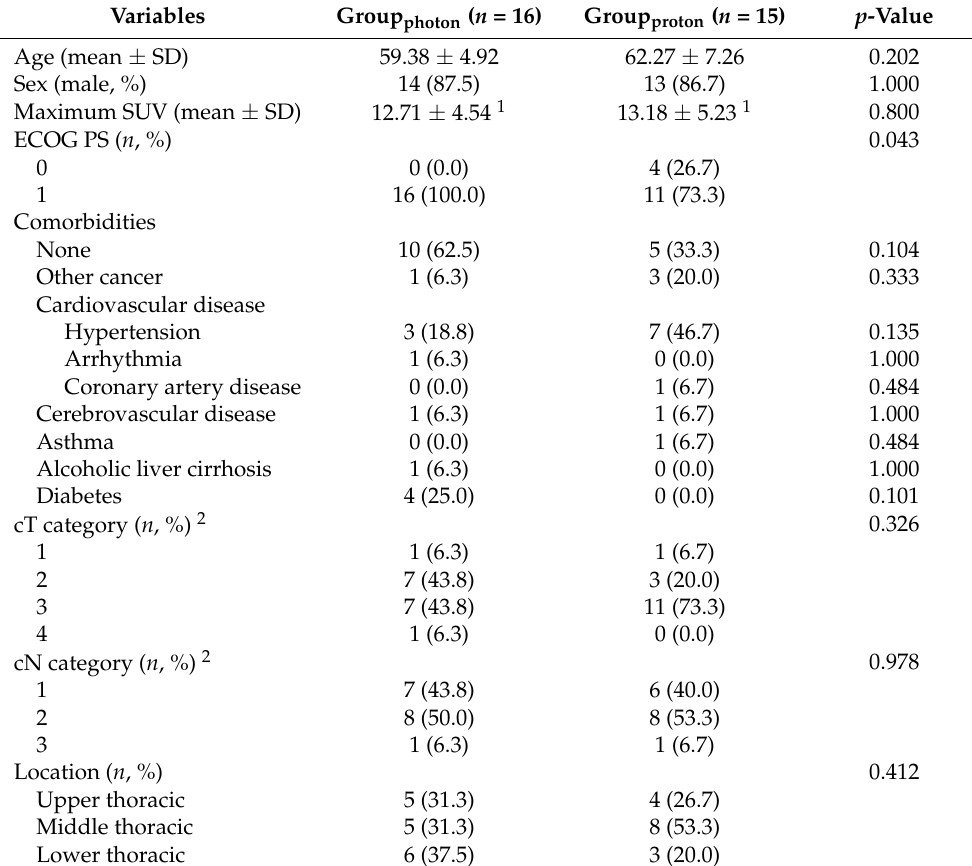
Table 1. Patient characteristics of Group photon and Group proton .